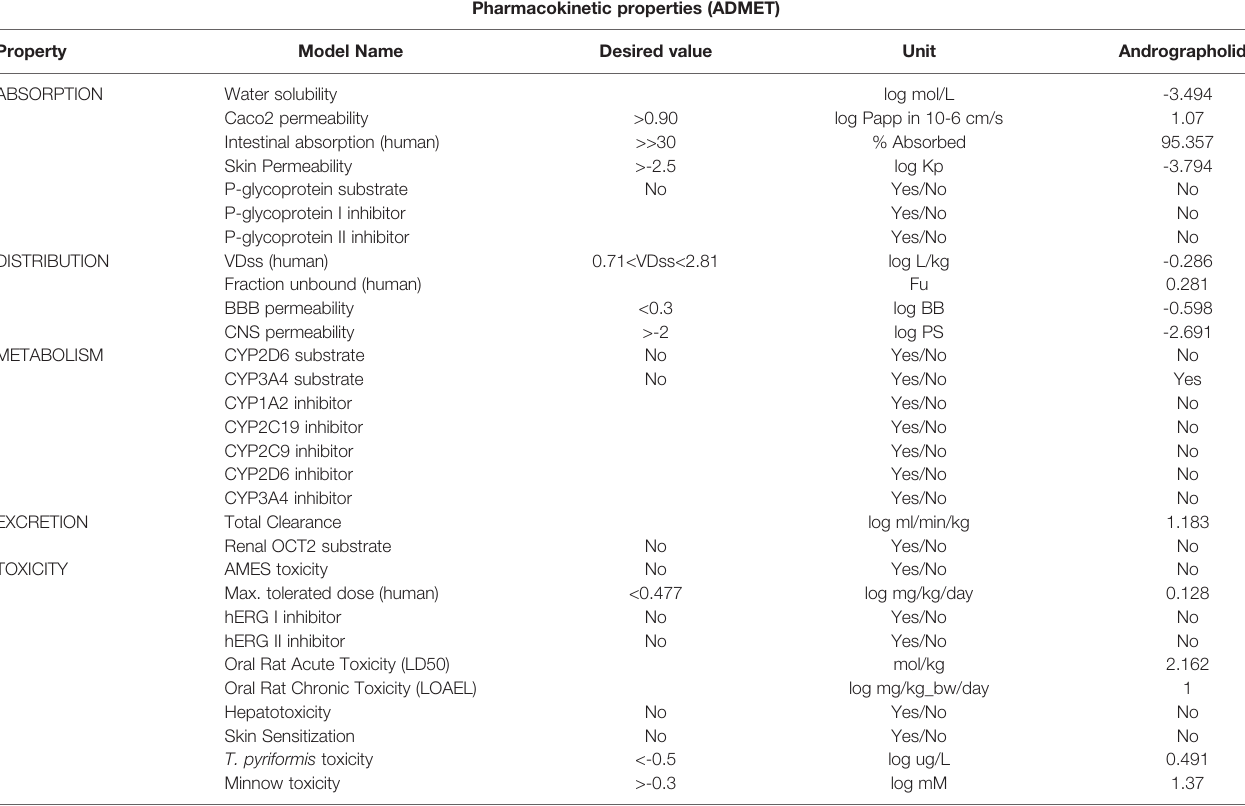
TABLE 3 | Pharmacokinetic properties (ADMET) prediction for